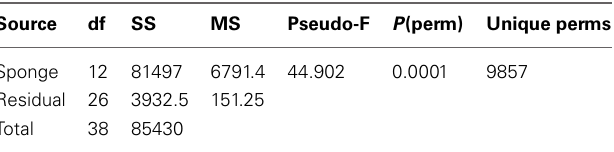
Table 1 | Summary PERMANOVA statistics (as per Anderson et al., 2008) of the DGGE derived symbiont assemblages reveal that microbial communities differ significantly between host sponge species ( p = 0 . 0001).